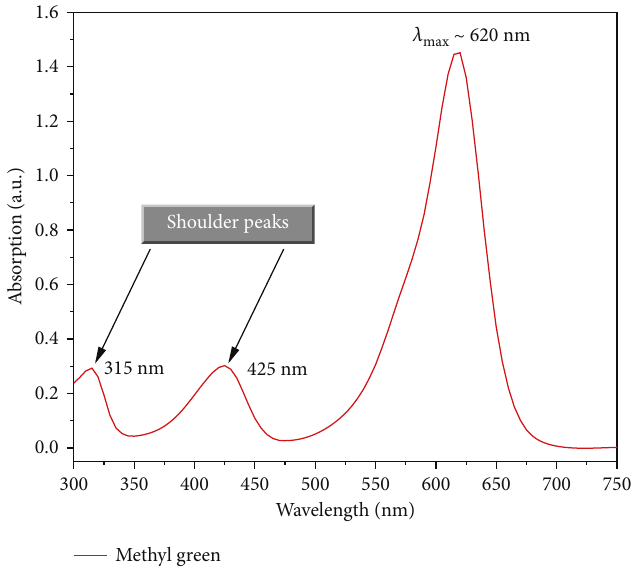
Figure 7: The solution state (DI water) absorption spectrum of methyl green pollutant